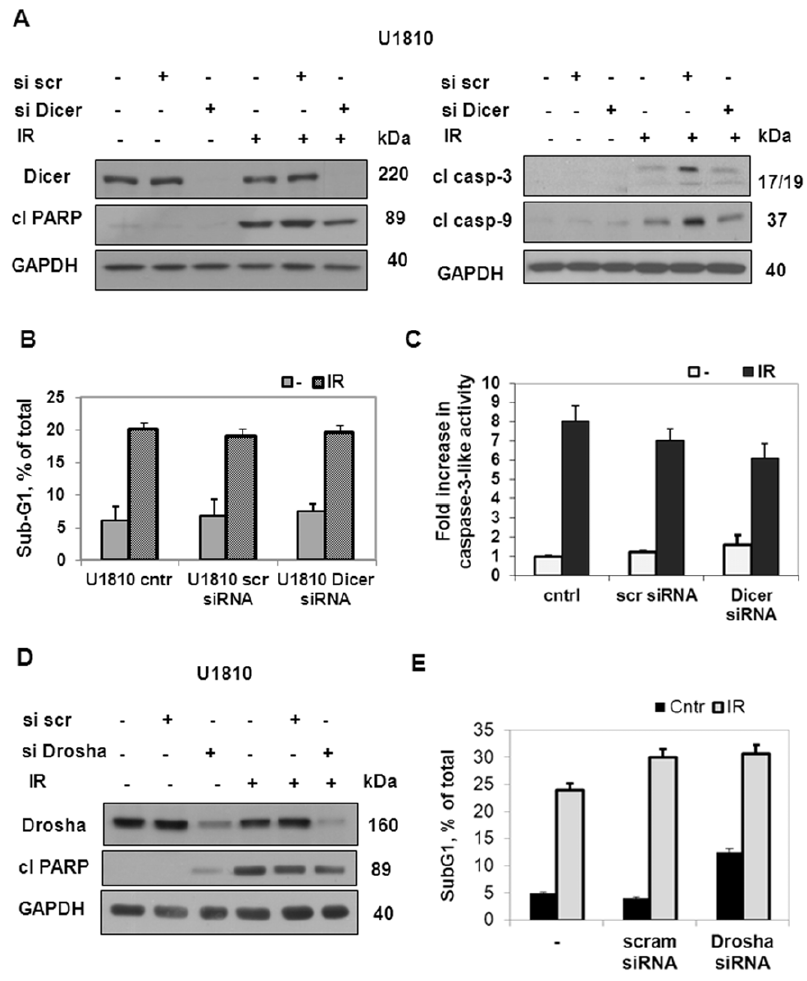
Figure 3. Knock-down of Dicer and Drosha is not sufficient to sensitize NSCLC cells to irradiation. (A) The level of Dicer expression, cleavage of PARP and processing of caspase-3 and -9 in U1810 cells transfected (48 h) with control (si scr) or Dicer (siDicer) siRNA assessed by Western blot 48 h after irradiation. Equal loading was verified using anti-GAPDH antibodies. Data are representative of three independent experiments. (B) Detection of apoptotic cell death in U1810 assessed by measuring the sub-G1 population after transfection (48 h) with control or Dicer siRNA and irradiation treatment (48 h). (C) Caspase-3-like activity (fold increase with respect to control) in U1810 cells after treatment with either irradiation alone or in combination with transfection of control or Dicer siRNA (for details see Materials and methods). (D) The level of Drosha expression and cleavage of PARP in U1810 cells transfected (48 h) with control (si scr) or Drosha (siDrosha) siRNA analyzed by Western blot 48 h after treatment with irradiation. Equal loading was verified using anti-GAPDH antibodies. All data are representative of three independent experiments. (B) Apoptotic cell death in U1810 measured by analysis of the sub-G1 population after transfection (48 h) with control or Drosha siRNA and irradiation treatment (48 h). Results shown are the mean 6 S.E.M. of three independent